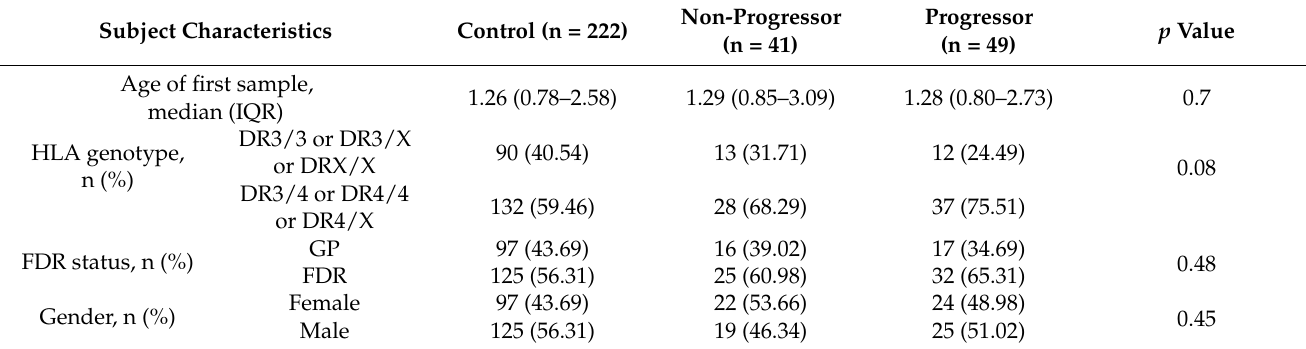
Table 1. Baseline characteristics of the DAISY study participants (n =